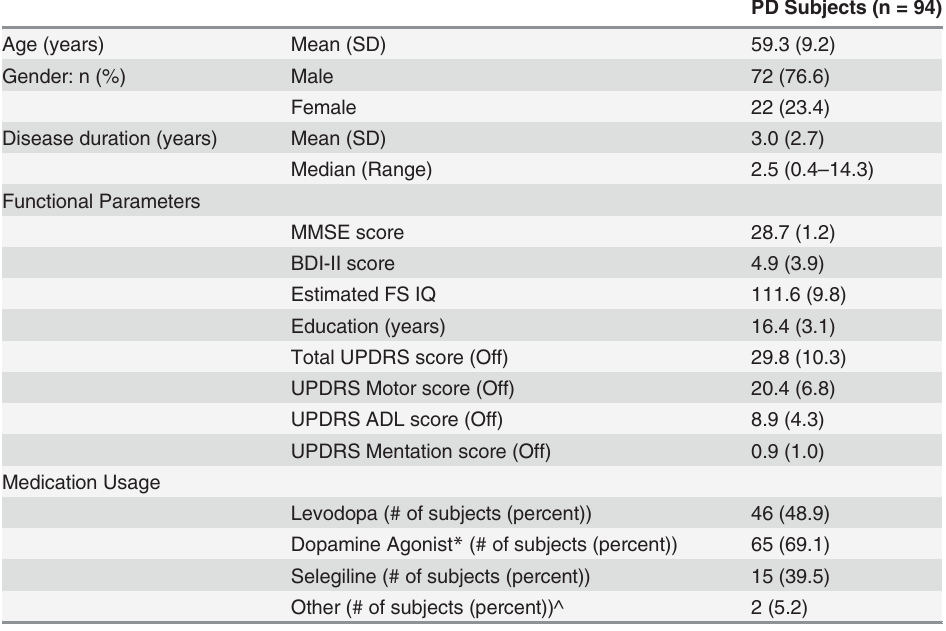
Table 1. Subject Demographics and Baseline